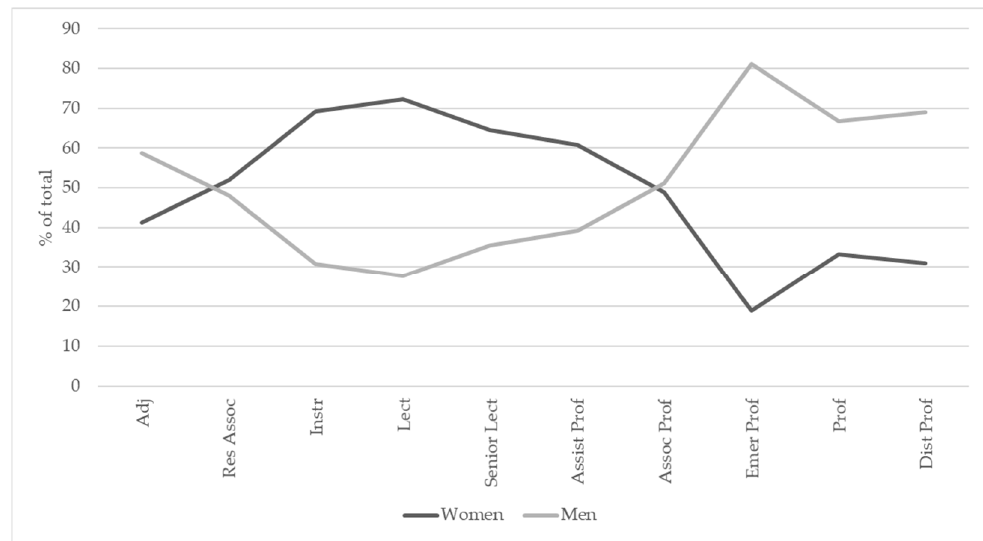
Figure 3. “Double” scissor diagram showing the gender distribution within different academic levels in USA/Canada veterinary schools.